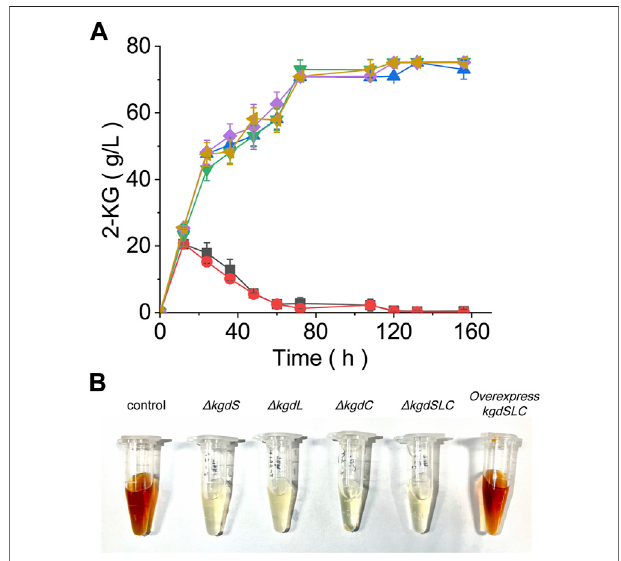
FIGURE 3 | Evaluating the fermentation performance of the kgdSLC knockout strain. (A) Changes in 2-KG concentrations in fermentation broth after kgdSLC knockout and overexpression. Green = kgdL knockout. Yellow = kgdS knockout. Blue = kgdC knockout. Purple = combined knockout. Red = Overexpressed kgdSLC . Black = control cells. (B) Broth color changes after kgdSLC knockout.Regardlessofsingleorcombinedknockout,thebroth no longer turned brown; when kgdSLC was overexpressed, the color of the fermentation broth turned